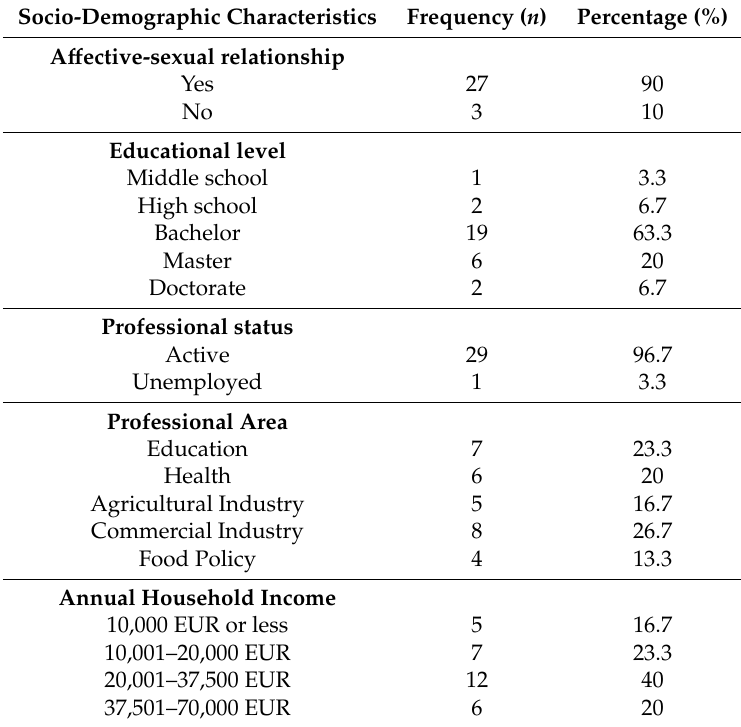
Table 1. Participants’ socio-demographic